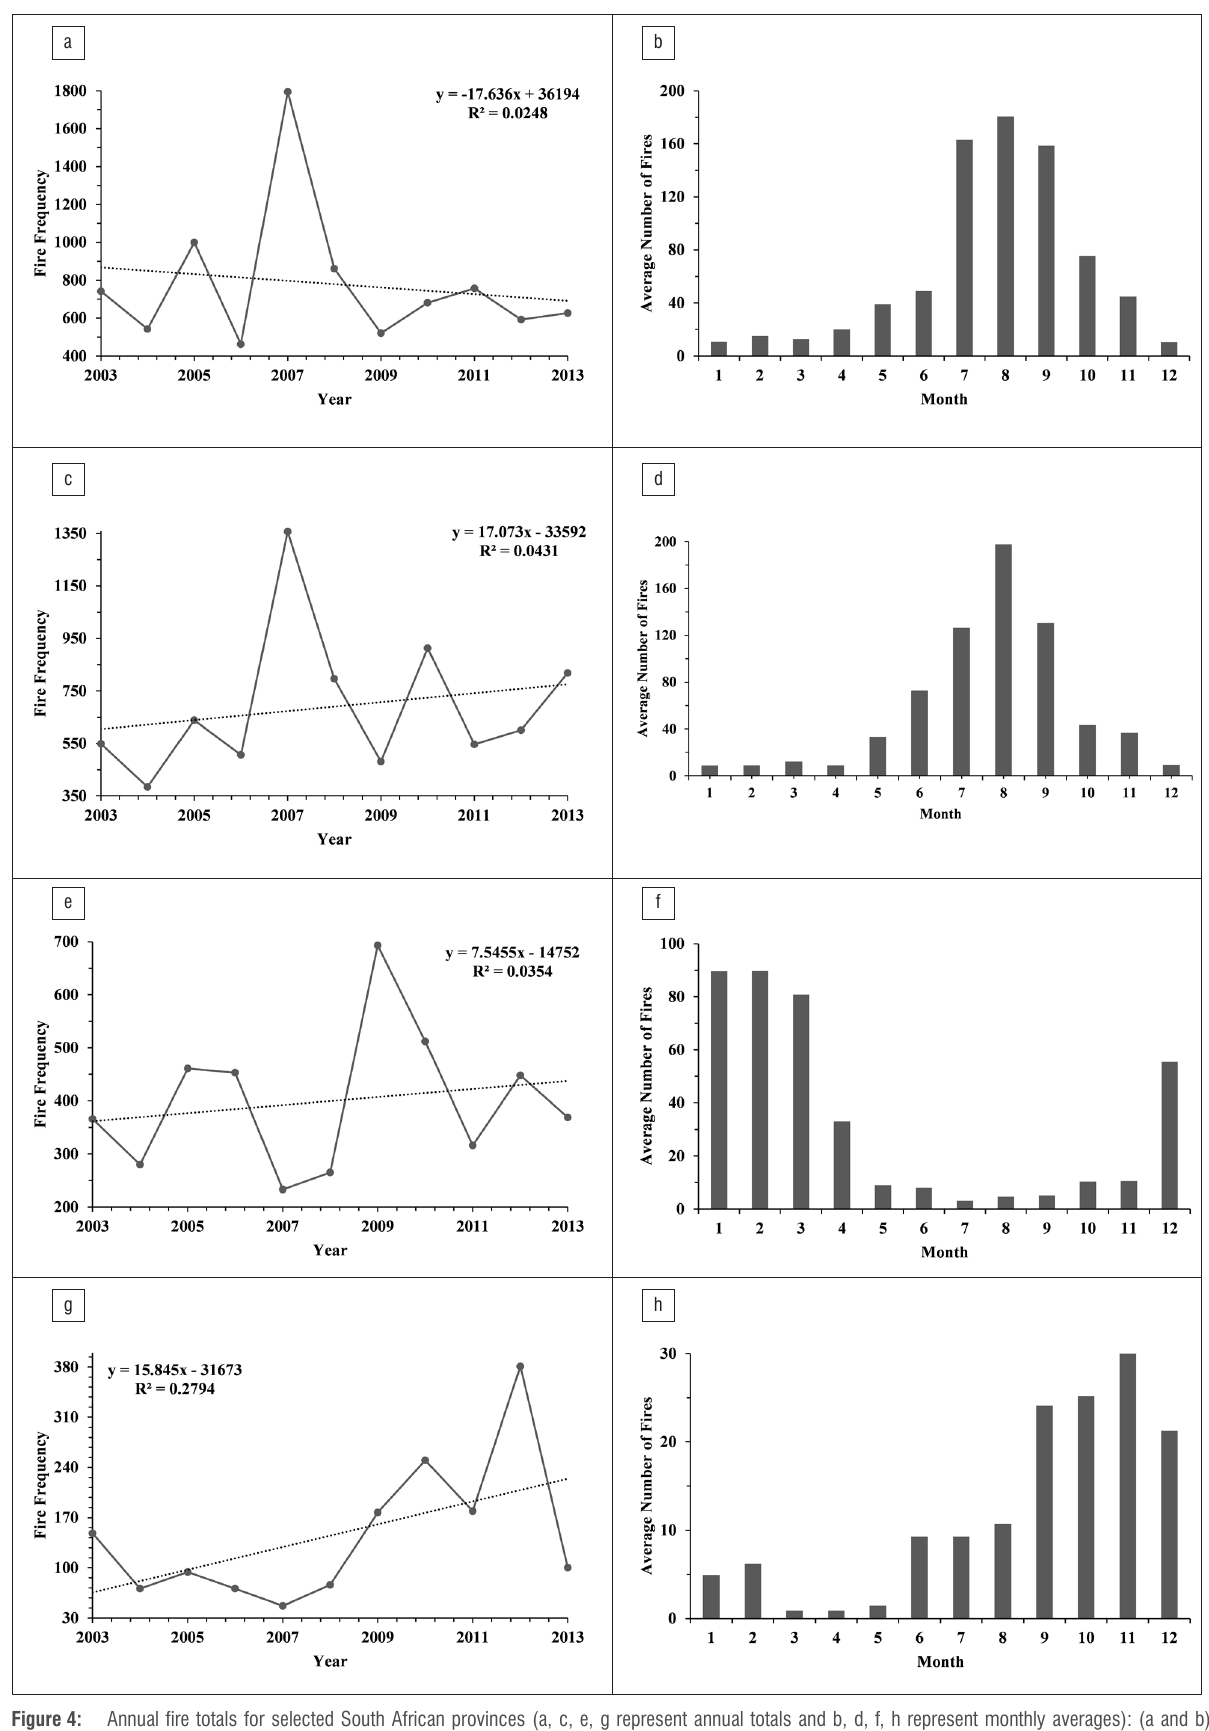
Figure 4: Annual fire totals for selected South African provinces (a, c, e, g represent annual totals and b, d, f, h represent monthly averages): (a and b) Mpumalanga, (c and d) KwaZulu-Natal, (e and f) Western Cape and (g and h) Northern